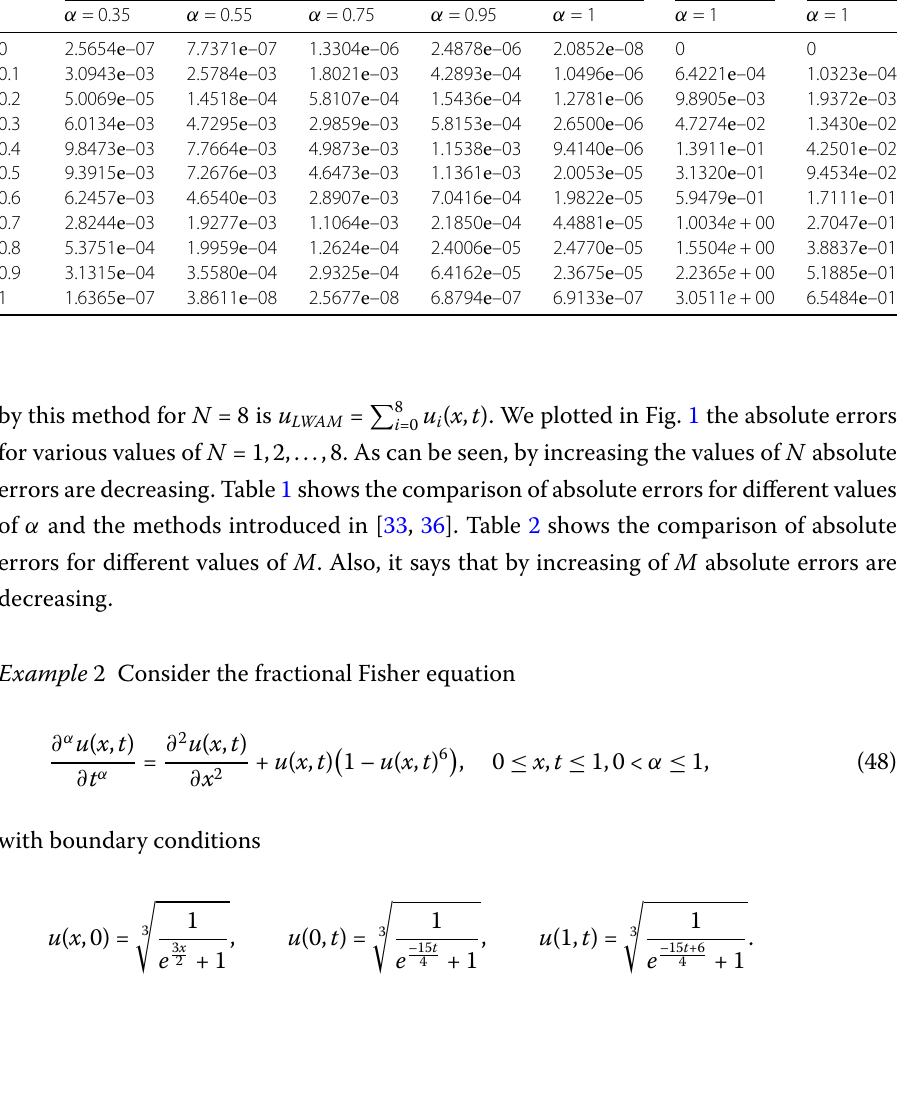
Table 1 Absolute errors for N = 8, k = 3, M = 5, various values of α when it goes to α = 1, and comparison of the absolute error with HPM [33] and MVIM [36] in Example 1 x = t E LWAM HPM MVIM α =